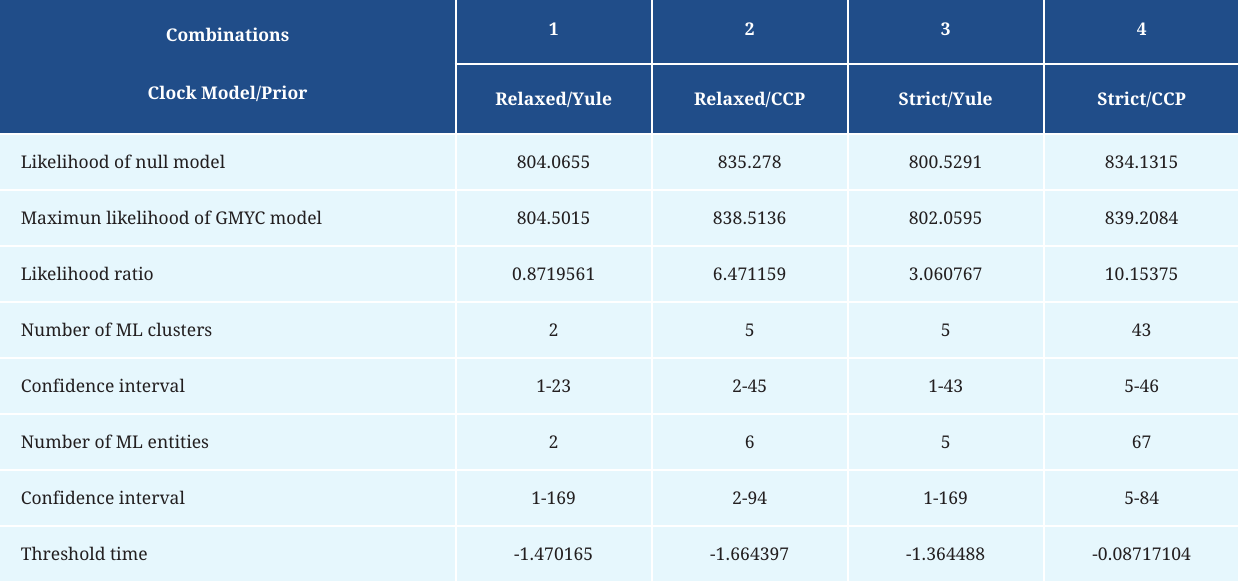
TABLE 2 | Comparative results of GMYC species delimitation for each Clock/Prior combination tested.